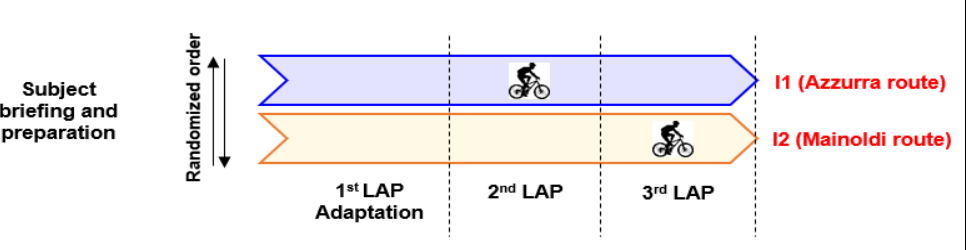
Figure 3. Overview of the experimental protocol, consisting of two main driving tasks, different in terms of cyclist presence and performed in a randomized order.